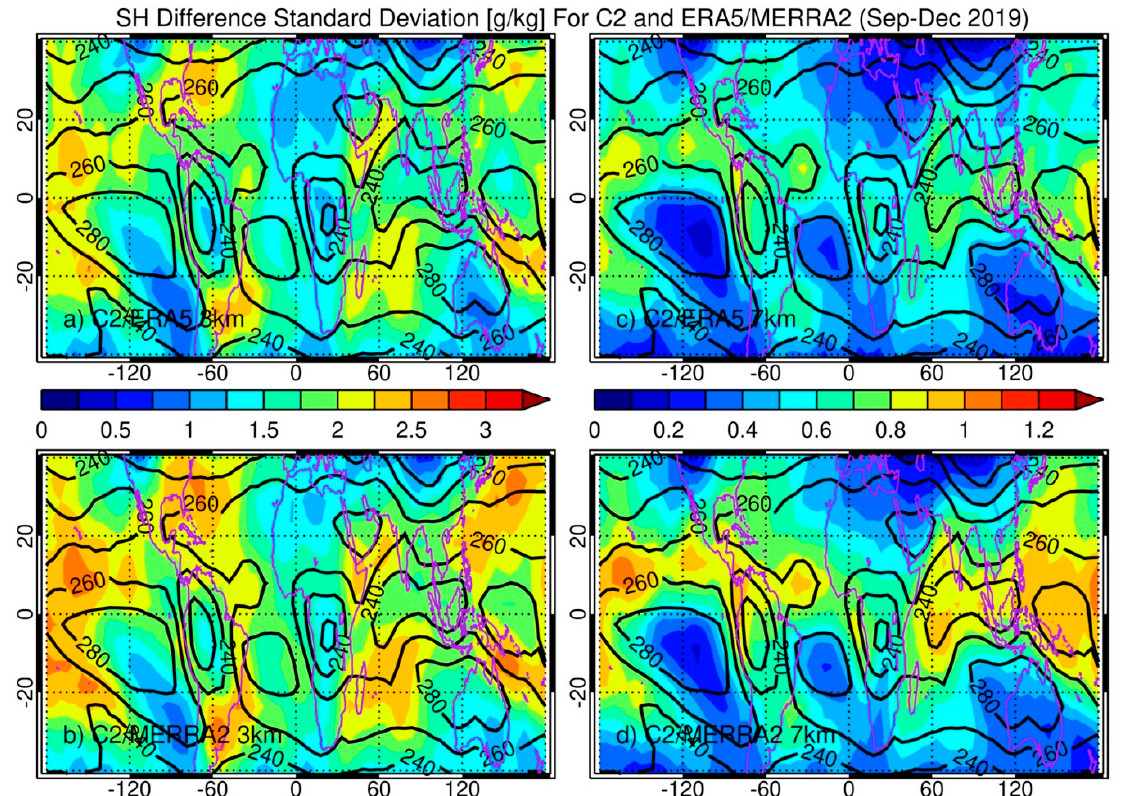
Figure 7. ( a , c ) C2 and ERA5 standard deviation of specific humidity differences (g/kg, color contours) at 3 km and 7 km, and ( b , d ) C2 and MERRA-2 standard deviation of specific humidity differences (g/kg, color contours) at 3 km and 7 km along with the mean outgoing longwave radiation (OLR, solid black contours) from ERA5 within 40° N–40° S from Sep- tember–December 2019.